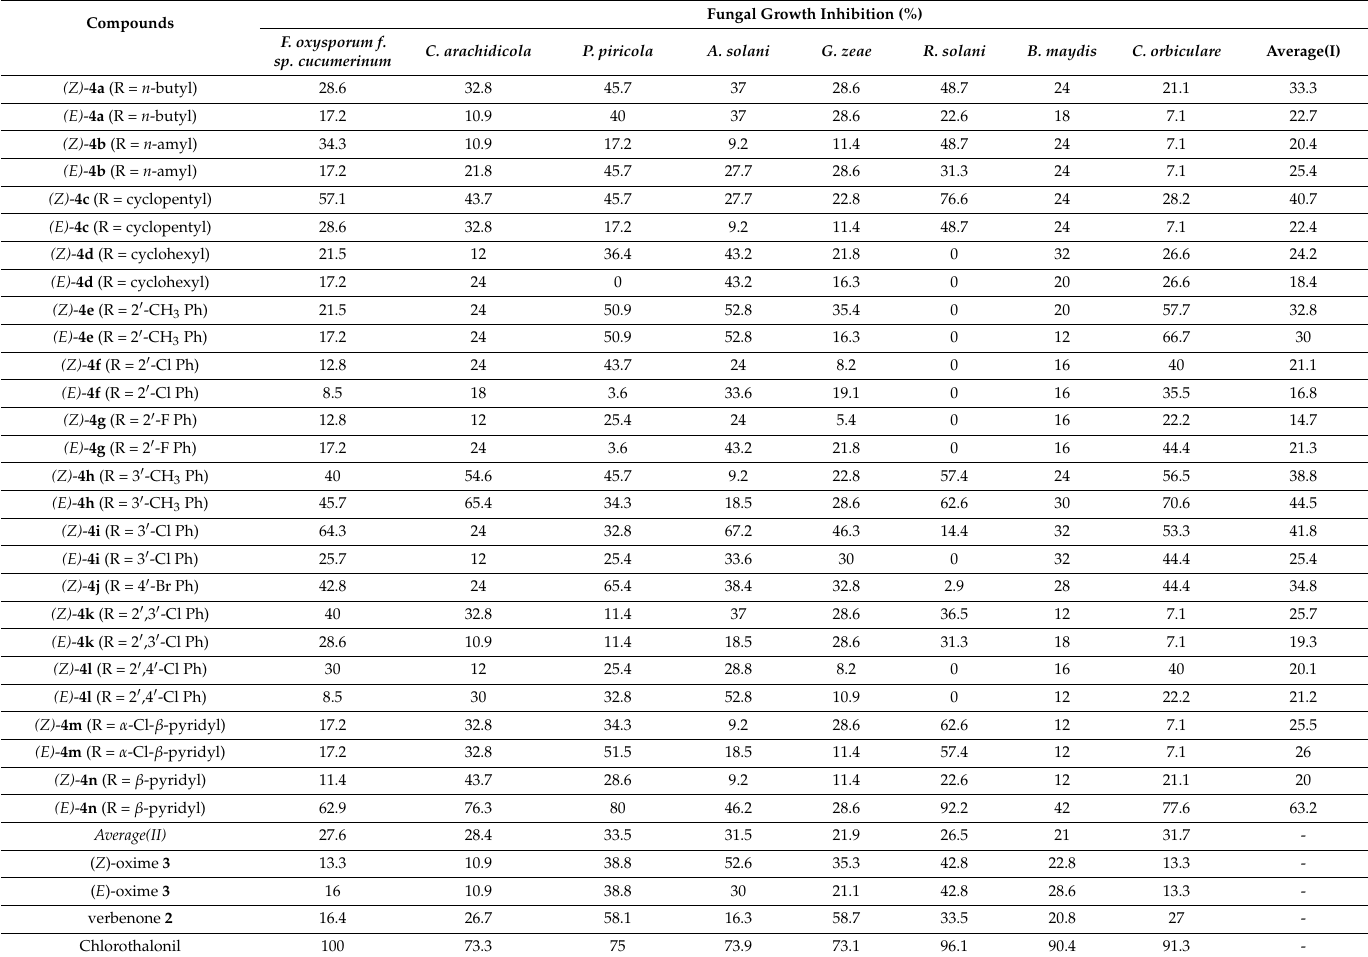
Table 1. Antifungal activity of the target compounds ( Z )- and ( E )- 4a – 4n at 50 µ